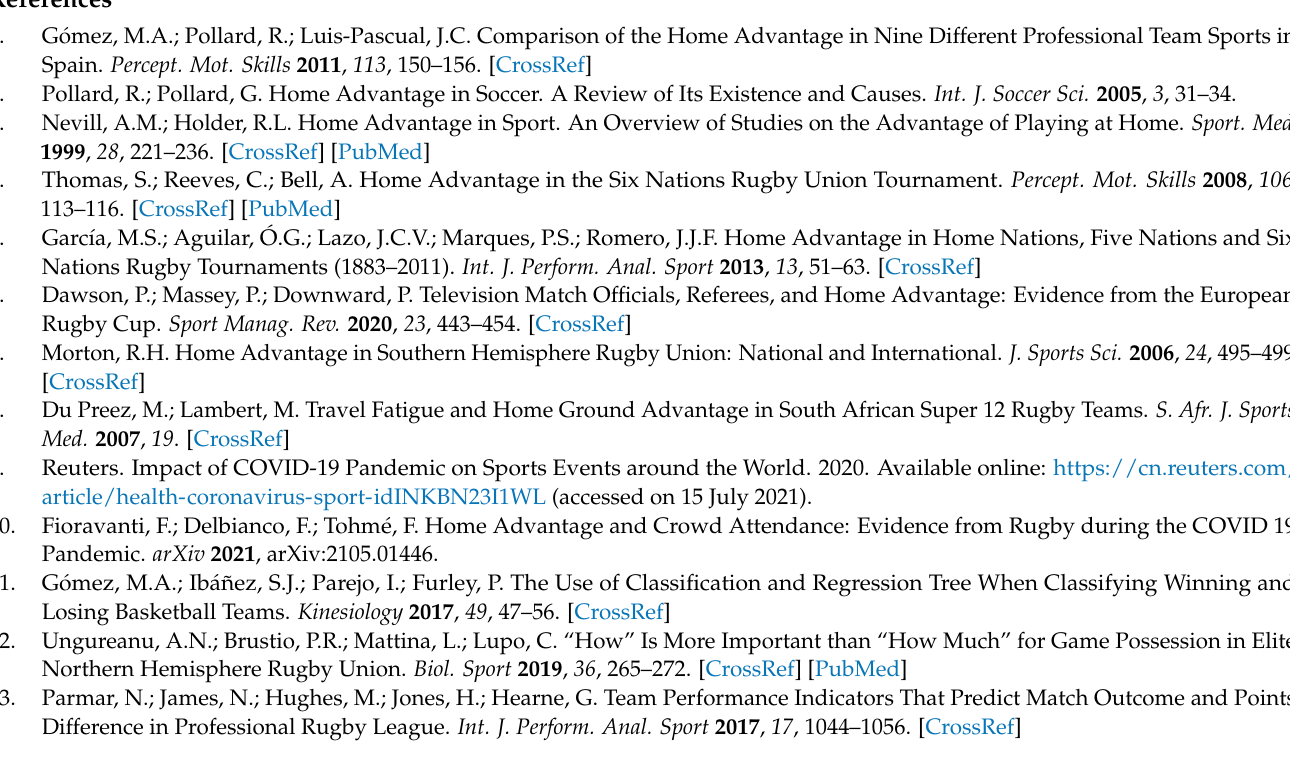
Figure S3: Away balanced games, Figure S4: Away unbalanced games, Table S1. EXHAUSTIVE CHAID decision tree